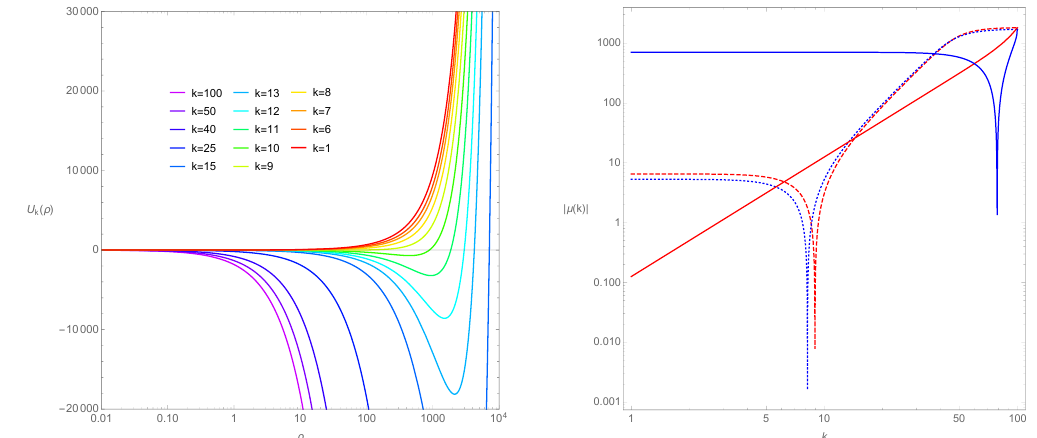
Figure 8 . Left panel: the flow of the dimensionful potential U k ( ρ ) at rank r = 5 in the n = 4 truncation between k = 100 and k = 1 with a = 1 for initial conditions at Λ = 100 close to the UV non-Gaussian fixed point in that truncation: Z (Λ) = 1 , µ (Λ) = − 0 . 86Λ 2 , λ 2 (Λ) = 0 . 090Λ 0 , λ 3 (Λ) = 0 . 084Λ − 2 and λ 4 (Λ) = 0 . 075Λ − 4 . Right panel: flow of the modulus of µ ( k ) in the n = 4 truncation for: (I) the system of non-autonomous β -functions (2.69) with a = 1 (dashed lines) and (II) the set of autonomous β -functions in the large-volume limit (3.16) (continuous lines). Initial conditions are the same as in the left panel except for µ (Λ) = − 0 . 91Λ 2 (red) and µ (Λ) = − 0 . 85Λ 2